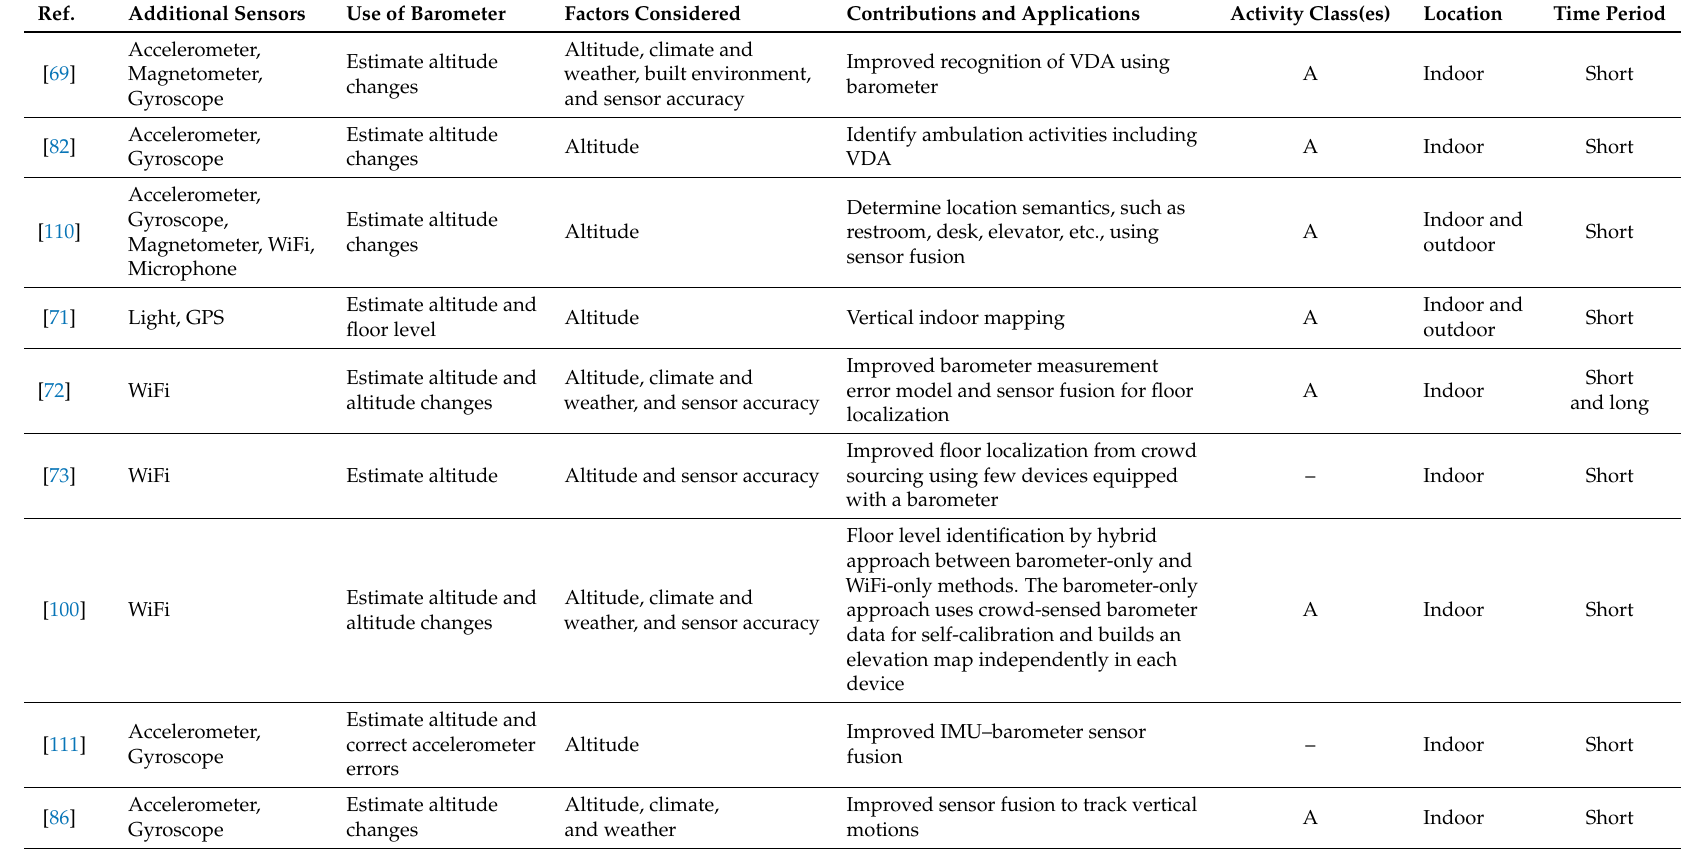
Table 2. Categorized literature related to the application or use of multi-sensors with barometers for human activity recognition. Two types of activity classes: (A) ambulation and (T)